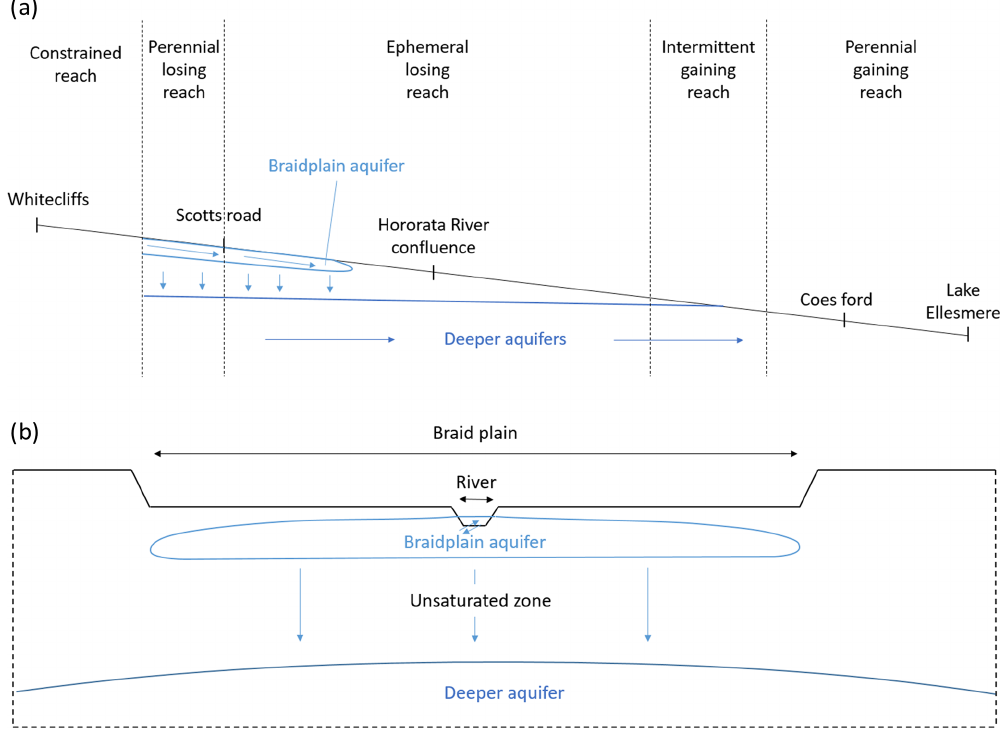
Figure 2. Schematic cross sections along (a) and across (b) the Selwyn River, its braidplain aquifer and the first deeper aquifer.